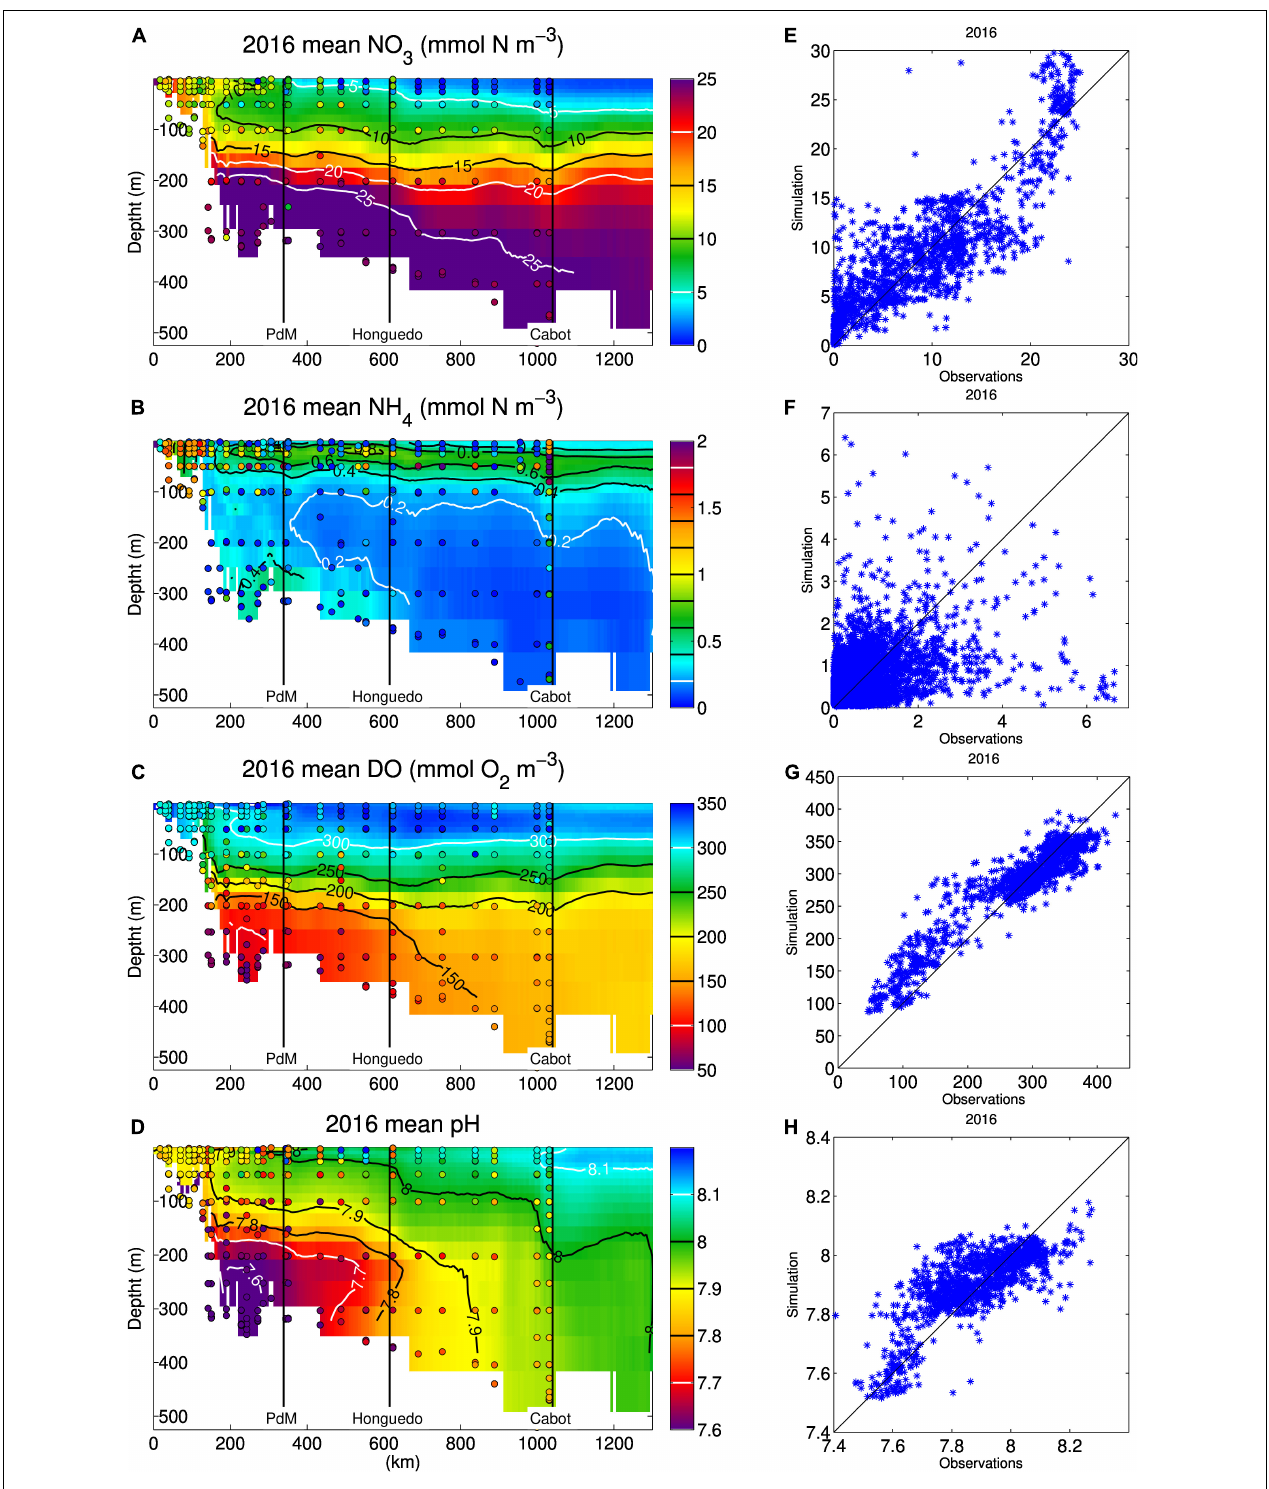
FIGURE 6 | Simulated annual means (background colors) along the Laurentian Channel transect (see Figure 1 ) for (A) nitrate (mmol N m − 3 ), (B) ammonium (mmol N m − 3 ), (C) dissolved oxygen (mmol O 2 m − 3 ), and (D) pH T in situ over the year 2016. The dots on top of the plot are observations made within 1 km of the Laurentian Channel transect ( Figure 1 ) in the same year (punctual values are thus compared to the annual mean). The right panels (E–H) show a point by point comparison, in time and space, with available data over the whole domain.